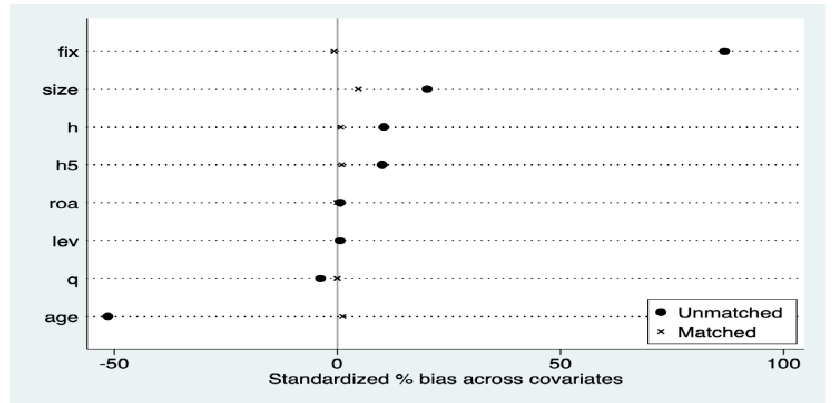
Figure 2. DID after propensity score matching. Table 11. Propensity score